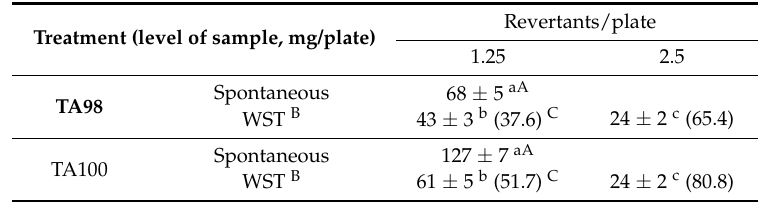
Table 2. Effect of WST extracts on the spontaneous mutagenicity of the Salmonella typhimurium TA98 and TA100 strain.